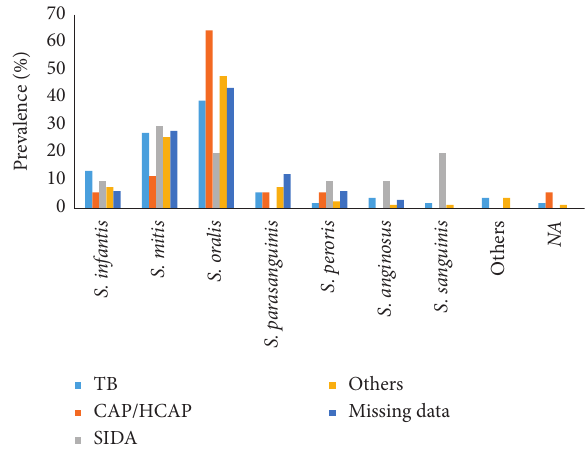
Figure 2: Prevalence of viridans group isolates isolated from adult patients with different clinical symptoms: tuberculosis (TB; blue bar), community-acquired pneumonia/healthcare-associated pneumonia (CAP/HCAP) (orange bar), SIDA/AIDS (gray bar), other symptoms (yellow bar), and missing data (blue dark